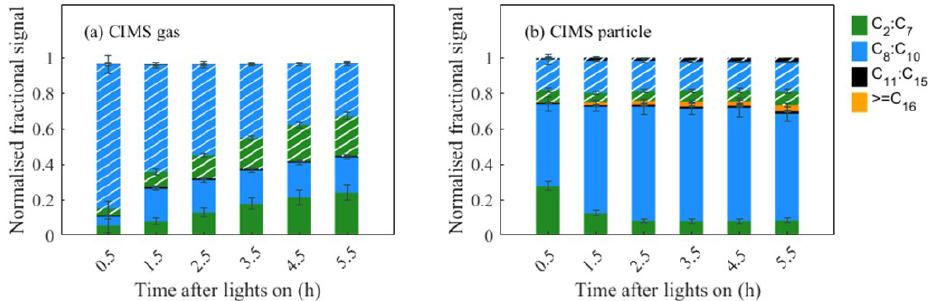
Figure 4. Evolution of chemical compounds in the gas phase and particle phase. Unhatched bars are the CHO group species; hatched bars are the CHON group species. (a) CIMS gas phase; (b) CIMS particle phase. Standard deviations ( n = 2) are indicated by error